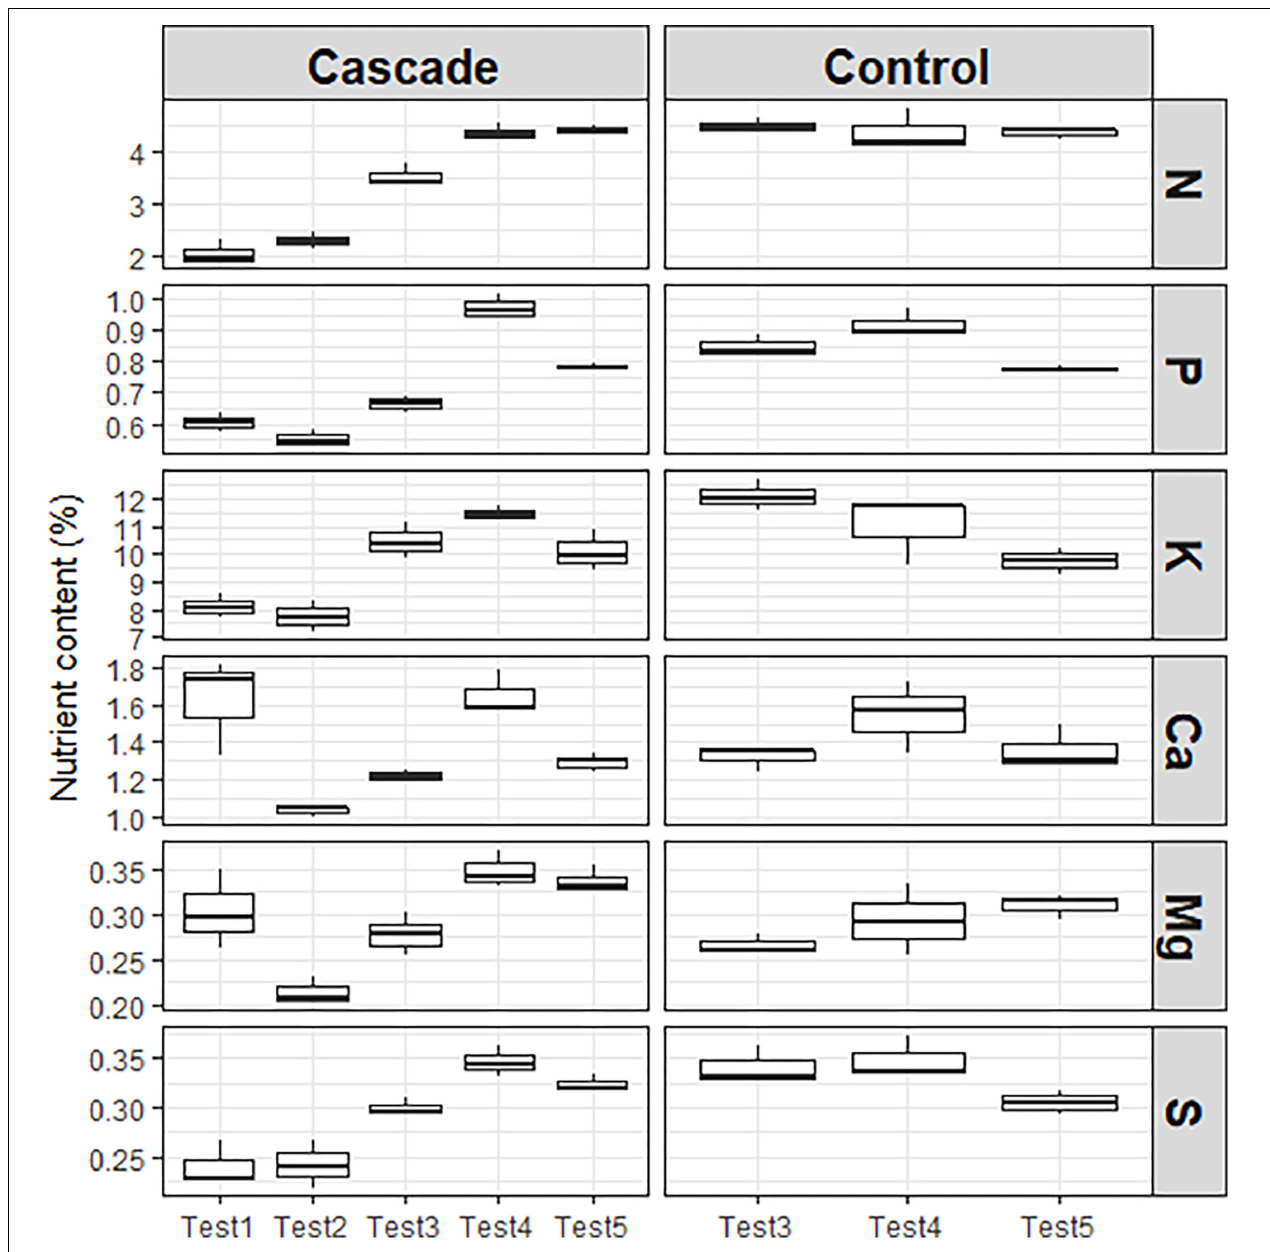
FIGURE 6 | Nutrient context per plant